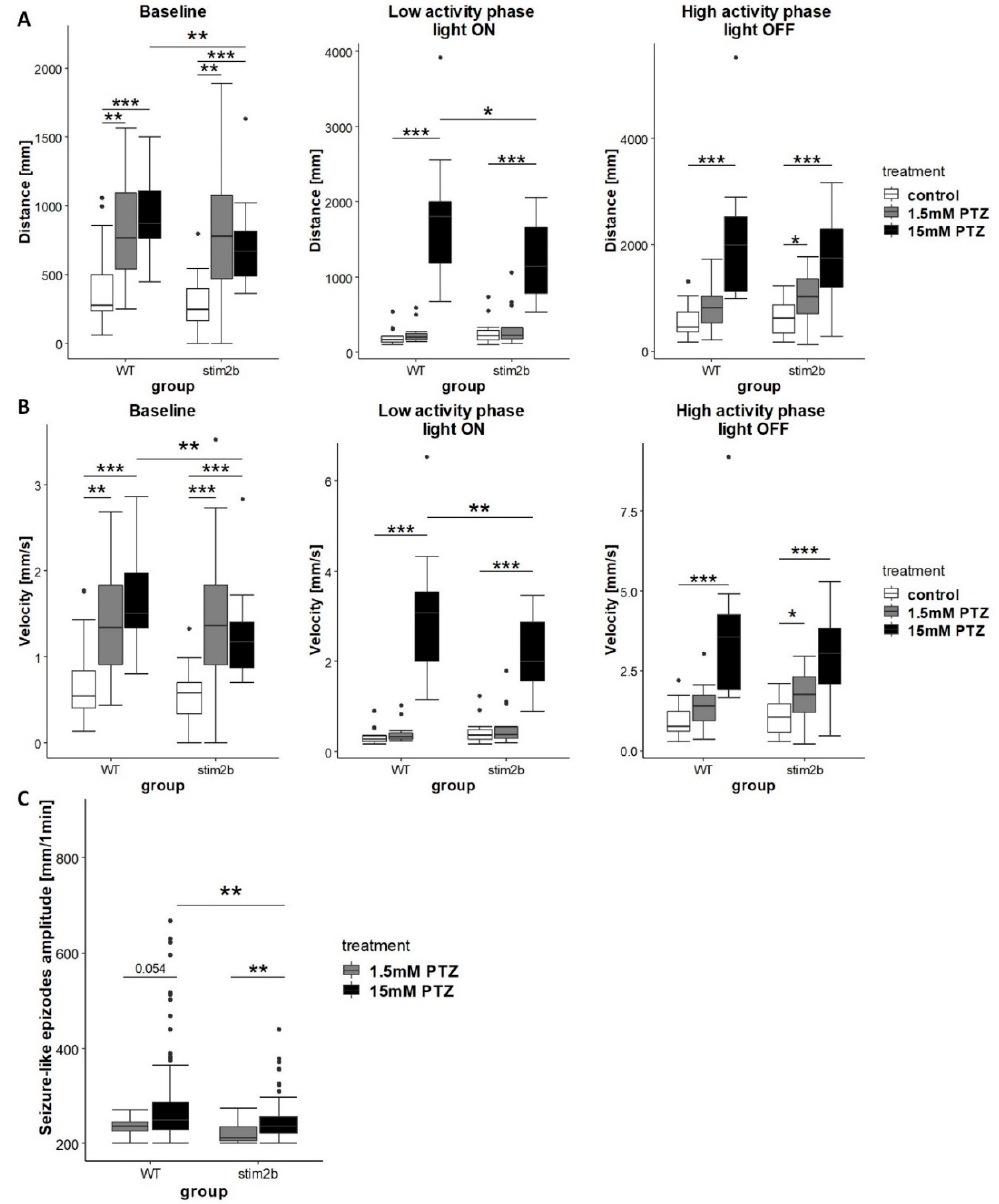
Figure 6. Treatment with the low dose of pentylenetetrazol (PTZ) induced stronger reaction of stim2b − / − than WT larvae and treatment with high dose of PTZ induce weaker reaction of stim2b − / − than WT larvae. The experimental design was the same as described in Figure 5A. Larva activity was recorded during a 30 min period that consisted of a baseline phase (0% light), low activity phase (70% light), and high activity phase (0% light). Before the experiment, half of the medium in the dish was exchanged with PTZ solution (final concentration: 1.5 or 15 mM). ( A,B ) Boxplots of the distance traveled ( A ) and velocity ( B ) in WT and stim2b − / − larvae during all phases of the experiment. ( C ) Boxplots of the average amplitude (distance traveled during 1 min) of seizure-like episodes that occurred during the experiment in WT and stim2b − / − larvae. Seizure-like episodes were defined as events of a long distance traveled within a short period of time (> 200 mm within 1 min). * p < 0.05, ** p < 0.01, *** p < 0.001, PTZ-treated larvae vs. control group of the same genotype (Wilcoxon–Mann–Whitney post hoc test with Benjamini and Hochberg correction) or mutant vs. WT with the same treatment (Wilcoxon rank-sum test). Number of larvae: n = 18 for all groups, with the exception of n = 14 WT that were treated with 1.5 mM PTZ. Number of experiments: 3.